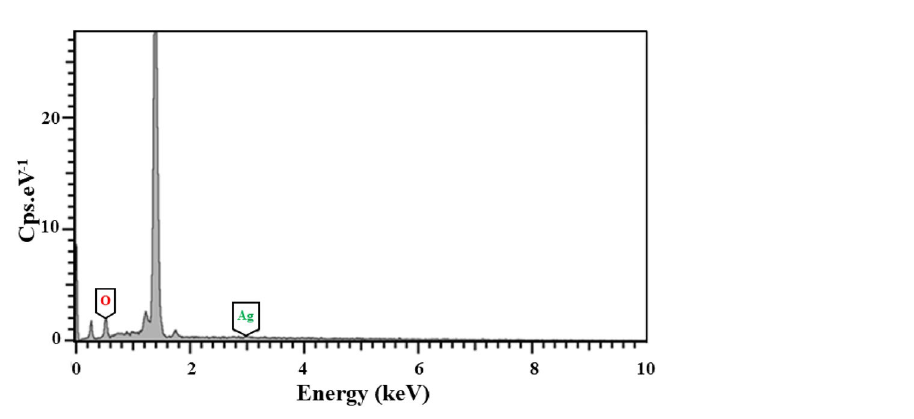
Figure 2. FESEM images of AgNPs at ( a ) 1 µm and ( b ) 300 nm.